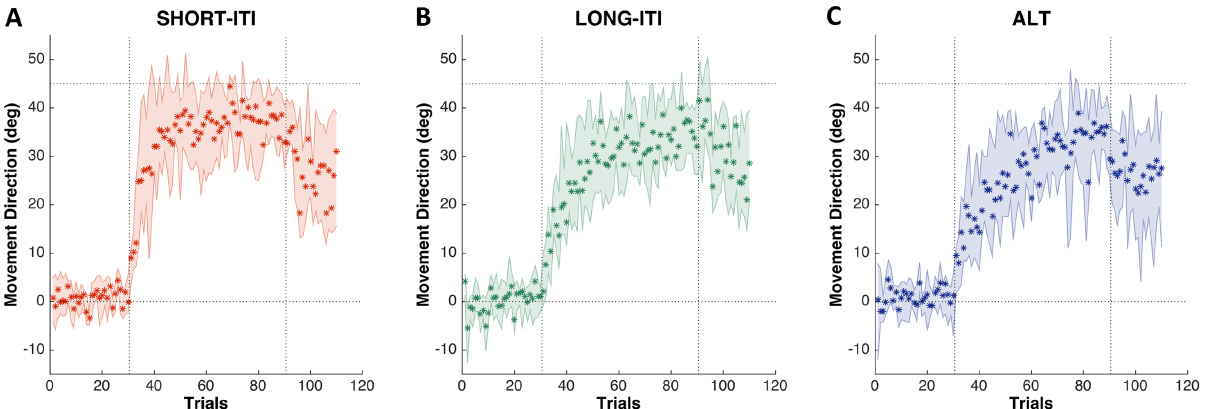
Fig 2. Observed subject behaviors in three experimental conditions. SHORT-ITI ( A ), LONG-ITI ( B ), and ALT ( C ). Star symbols: median subject performance. Shaded area: inter-quartile (25 – 75%)